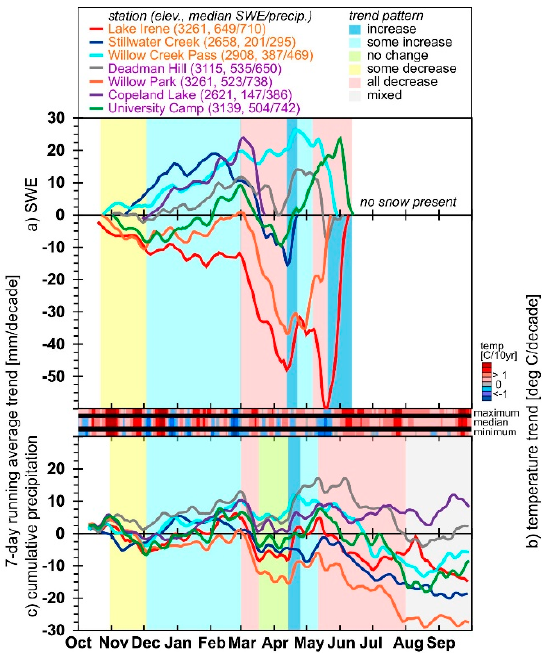
Figure 8. Seven-day running average trends ( a ) SWE, ( b ) temperature, and ( c ) cumulative precipitation for 7 of the 13 SNOTEL stations shown in Figure 3. The first three SNOTEL stations are on the west-side and presented as orange in the legend and the last four are on the east-side and presented as purple. The same color scheme is used from Figure 4. Time periods of increasing, somewhat increasing, no change, somewhat decreasing, all decreasing, and mixed (both increasing and decreasing) trends are presented as colored bands.